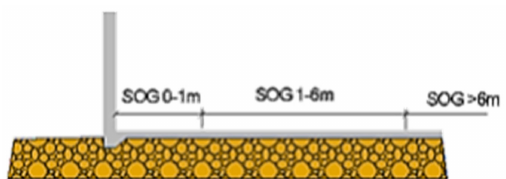
Figure 4. Di ff erent sections of the “slab on grade” (SOG) as the ground model in the VIP-Energy